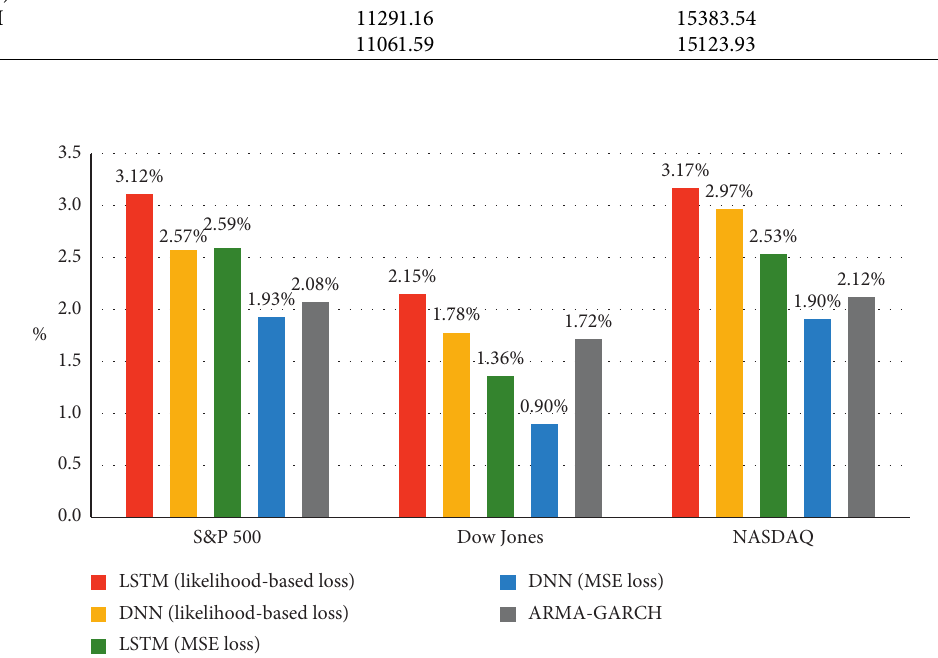
Figure 6: Log-likelihood improvements upon the simple method.